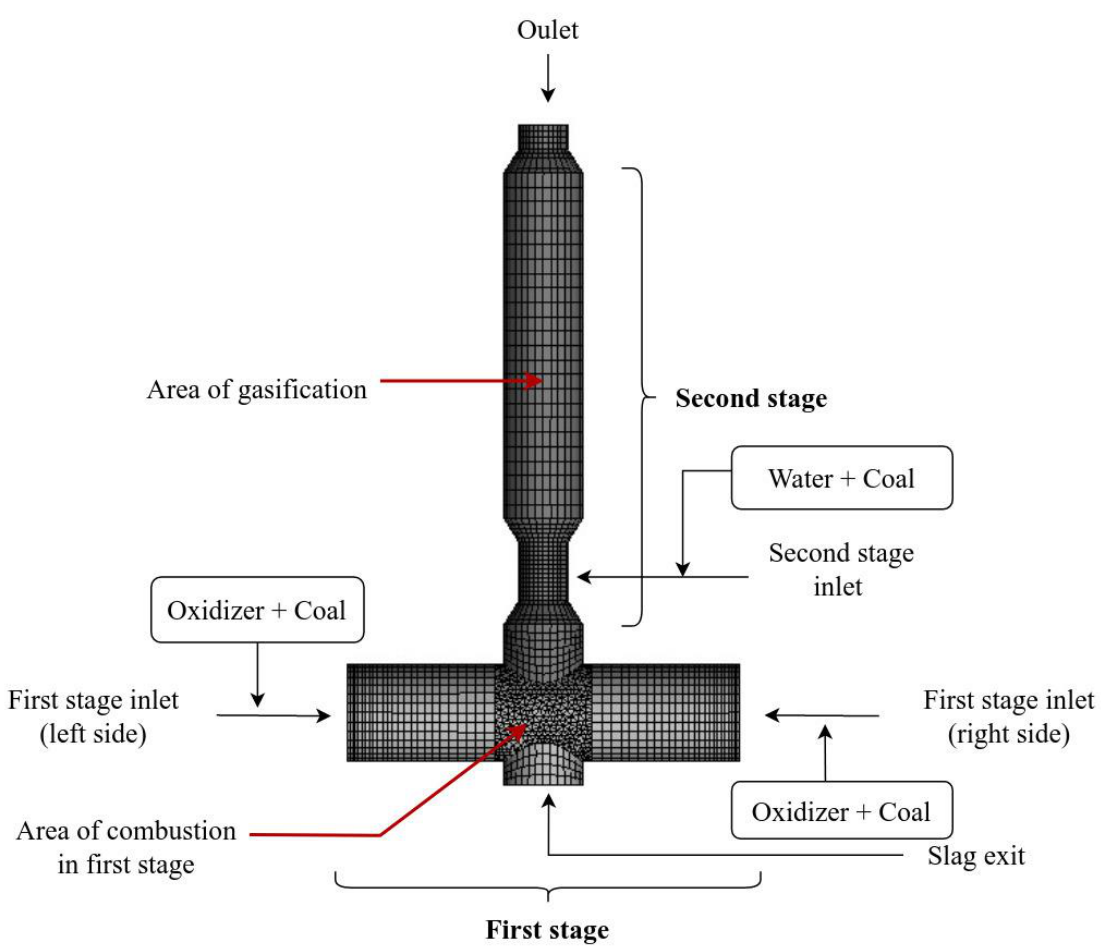
Figure 2. Details of the gasifier used in the study.